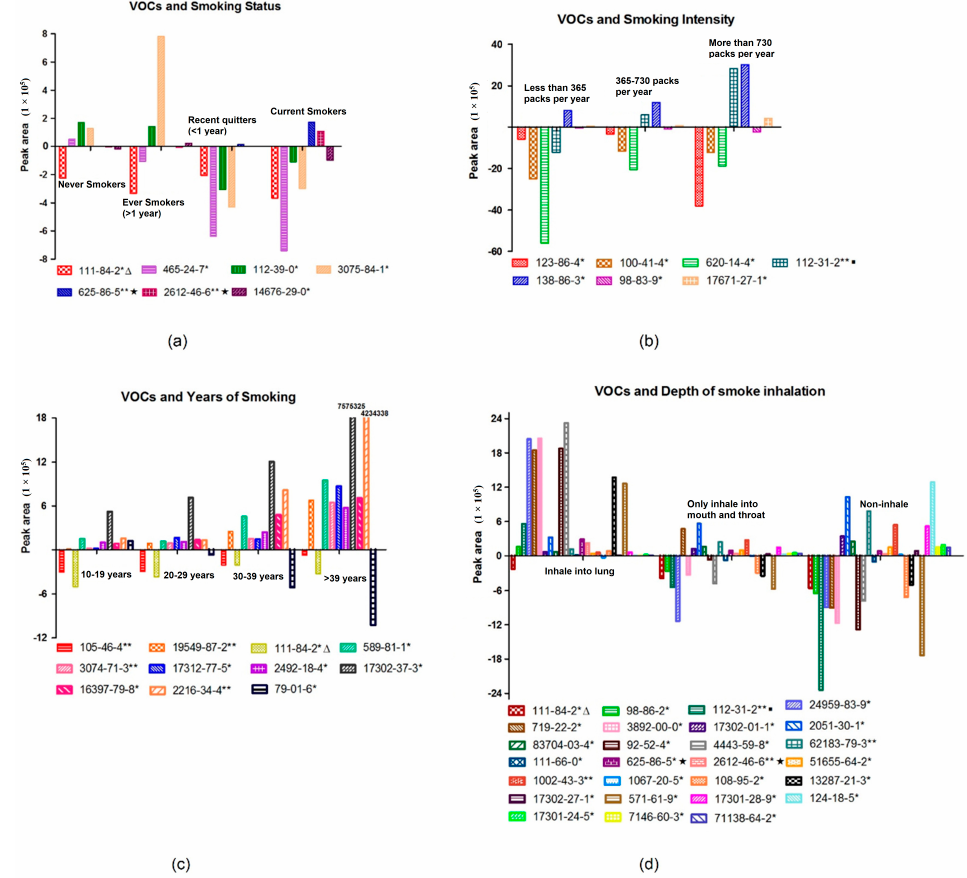
Figure 3. ( a ) VOCs that were correlated with smoking status; ( b ) VOCs that were correlated with smoking intensity; ( c ) VOCs that were correlated with years of smoking; ( d ) VOCs that were correlated with depth of smoke inhalation. (* denotes p < 0.05, ** denotes p < 0.01; sign ∆ means this compound was correlated with smoking status, years of smoking, and depth of smoke inhalation in the meanwhile, and sign (cid:110) was both correlated with smoking intensity and depth of smoke inhalation, while sign (cid:70) was both correlated with smoking status and depth of smoke